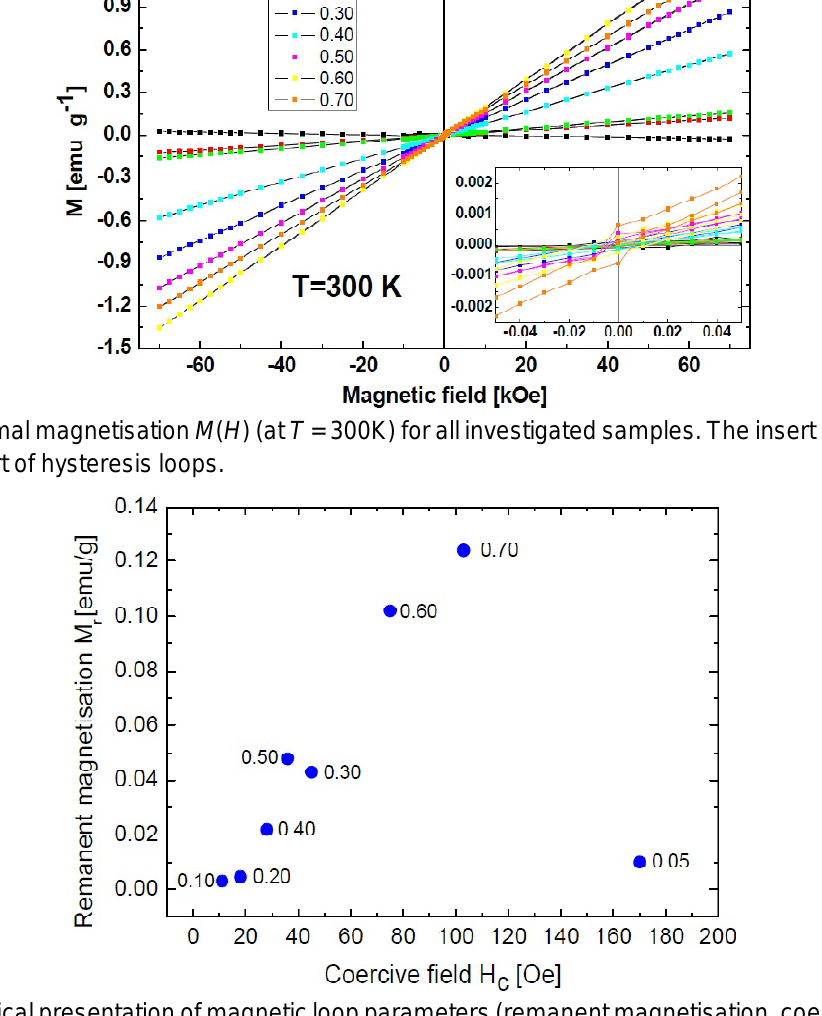
Fig. 10. Graphical presentation of magnetic loop parameters (remanent magnetisation, coercive field) de- termined at T = 2K for all studied samples.